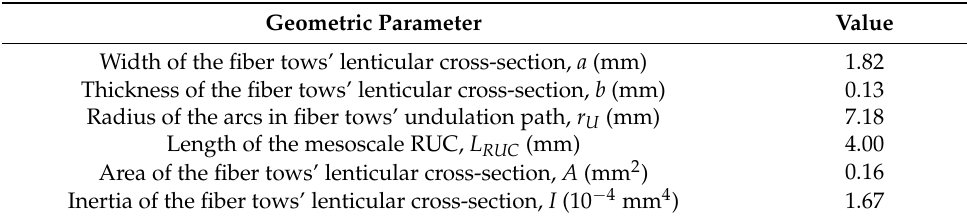
Table 2. Geometric parameters of fiber tows in the T300/Cycom970 plain-woven fabric composite. Geometric Parameter Value Width of the fiber tows’ lenticular cross-section, a (mm) 1.82 Thickness of the fiber tows’ lenticular cross-section, b (mm) 0.13 Radius of the arcs in fiber tows’ undulation path, r U (mm) 7.18 Length of the mesoscale RUC, L RUC (mm) 4.00 Area of the fiber tows’ lenticular cross-section, A (mm 2 ) 0.16 1.67